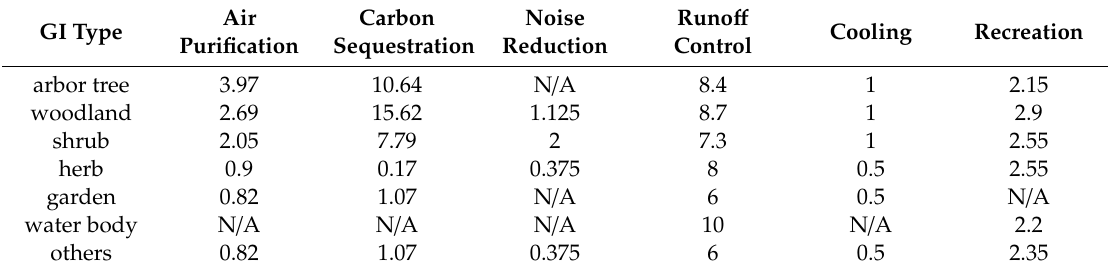
Table 3. Supply type and coe ffi cient